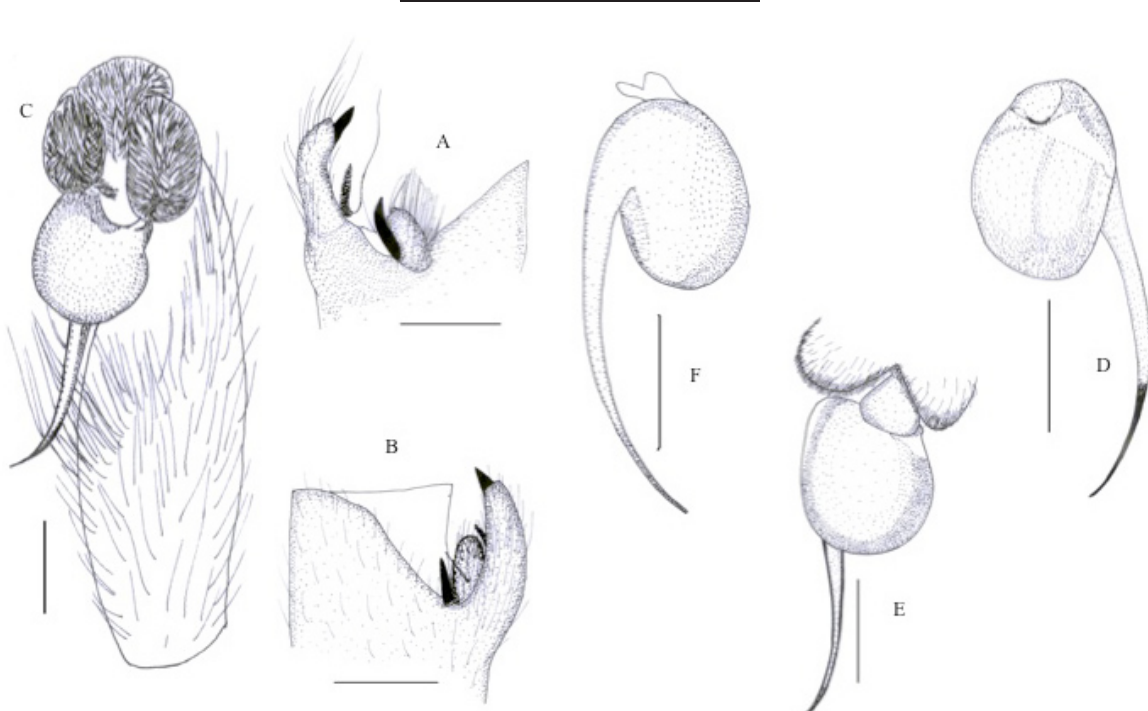
Figure 6. Neoheterophrictus sahyadri sp. nov., male (WILD-10-ARA-579). A - Tibial spur, prolateral view; B - Tibial spur, retrolateral view; C - Tibia to Palp, retrolateral view; D - Palp, Prolateral view; E - Palp, ventral view; F - Palp, retrolateral view. Scale 1.0mm for